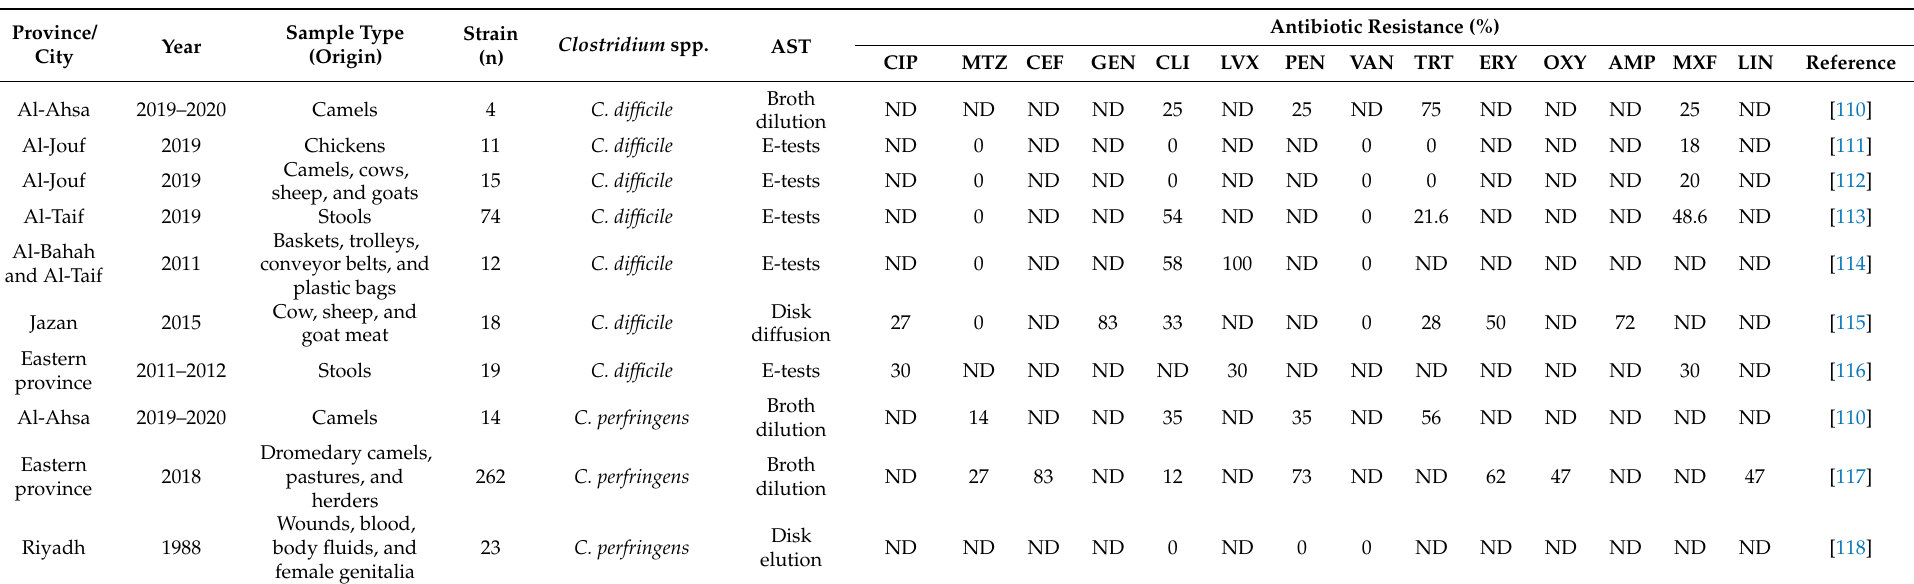
Table 2. Antibiotic Susceptibility of Clostridium spp. isolated in Saudi Arabia